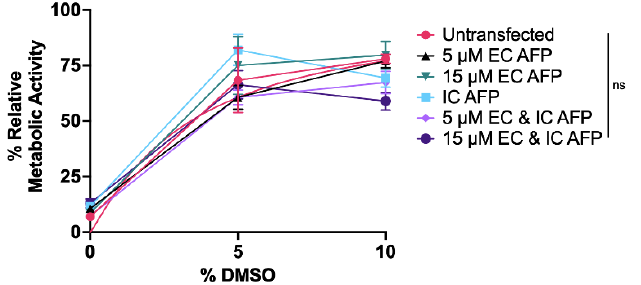
Figure 6. Relative metabolic activity assessed via MTS assay performed on untransfected and AFP- transfected (IC AFP) HEK 293T cells after cryopreservation. A total of 5 × 10 6 cells were cryopreserved with 0, 5, and 10% ( v / v ) concentrations of DMSO and/or 5 or 15 µM (0.132 or 0.396 mg/mL) TrxA-ApAFP752 (EC AFP) and stored in liquid nitrogen vapor phase ( − 196 °C) for ≥ 4 weeks. The medium was changed after 24 h and MTS assay was performed after 48 h with % metabolic activity measured relative to fresh, non-cryopreserved HEK 293T cells. Data were analyzed using a one-way analysis of variance (ANOVA) and Tukey’s post hoc test was used for pairwise comparisons of experimental groups. All experiments contained 3 biological repeats ( n = 3), with each containing 3 technical repeats. Mean value ± SEM (n.s. p >